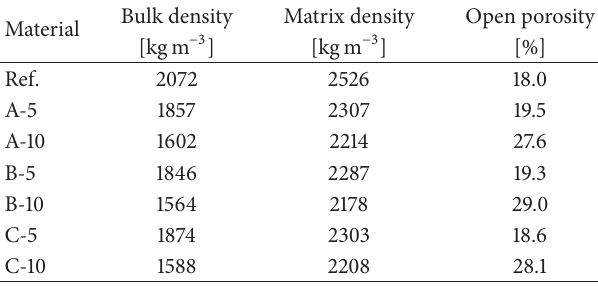
Table 6: Basic physical properties.